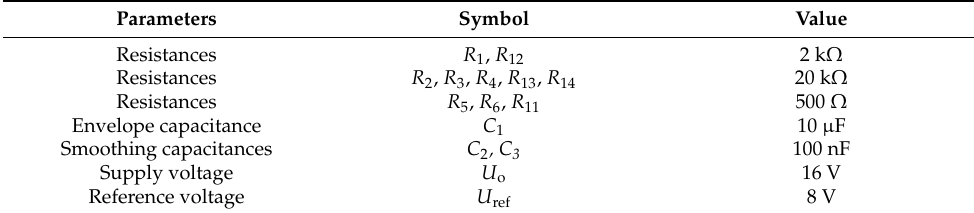
Table 3. Demodulation circuit parameters.